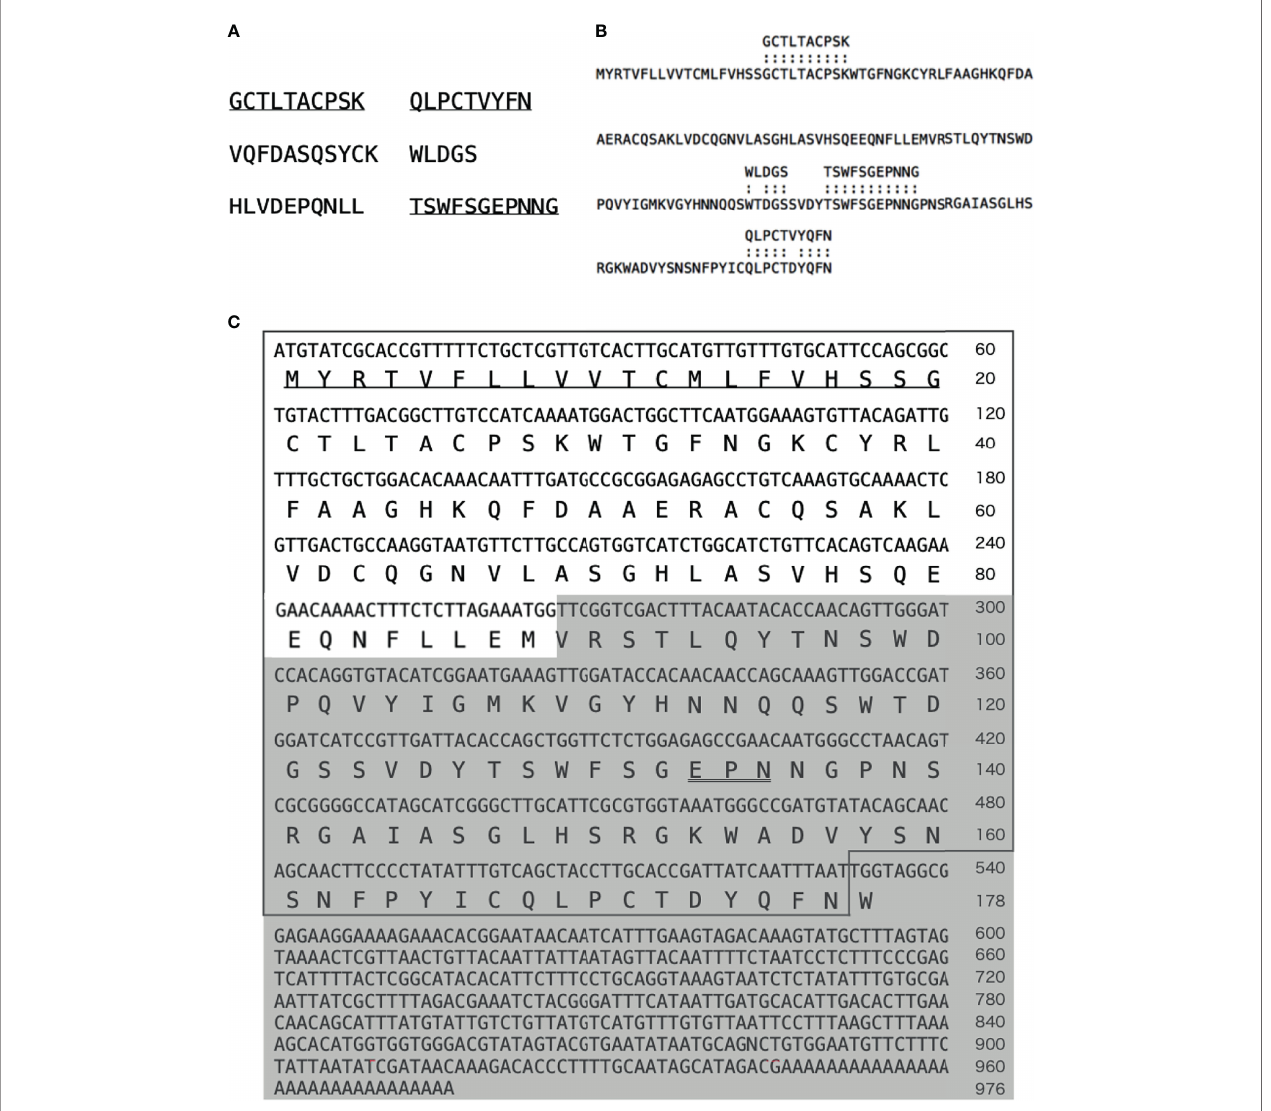
FIGURE 9 | Identi fi cation of the aggregation-promoting factor. (A) Peptide sequences obtained by de novo sequencing of the 16 kDa protein puri fi ed by anion- exchange and gel- fi ltration chromatography ( Figure 5C ). The sequences obtained by de novo sequencing of the protein puri fi ed by galactose-af fi nity chromatography ( Figure 7A ), as well, are underlined. (B) A sequence found in RNA-seq data that is highly identical to the peptide sequences. (C) cDNA sequence and deduced amino acid sequence of AjGBCL. The sequence obtained by RNA-seq is boxed. The sequence of partial and 3 ′ -RACE ampli fi ed cDNA con fi rmed by sequencing in shaded. An EPN motif is double